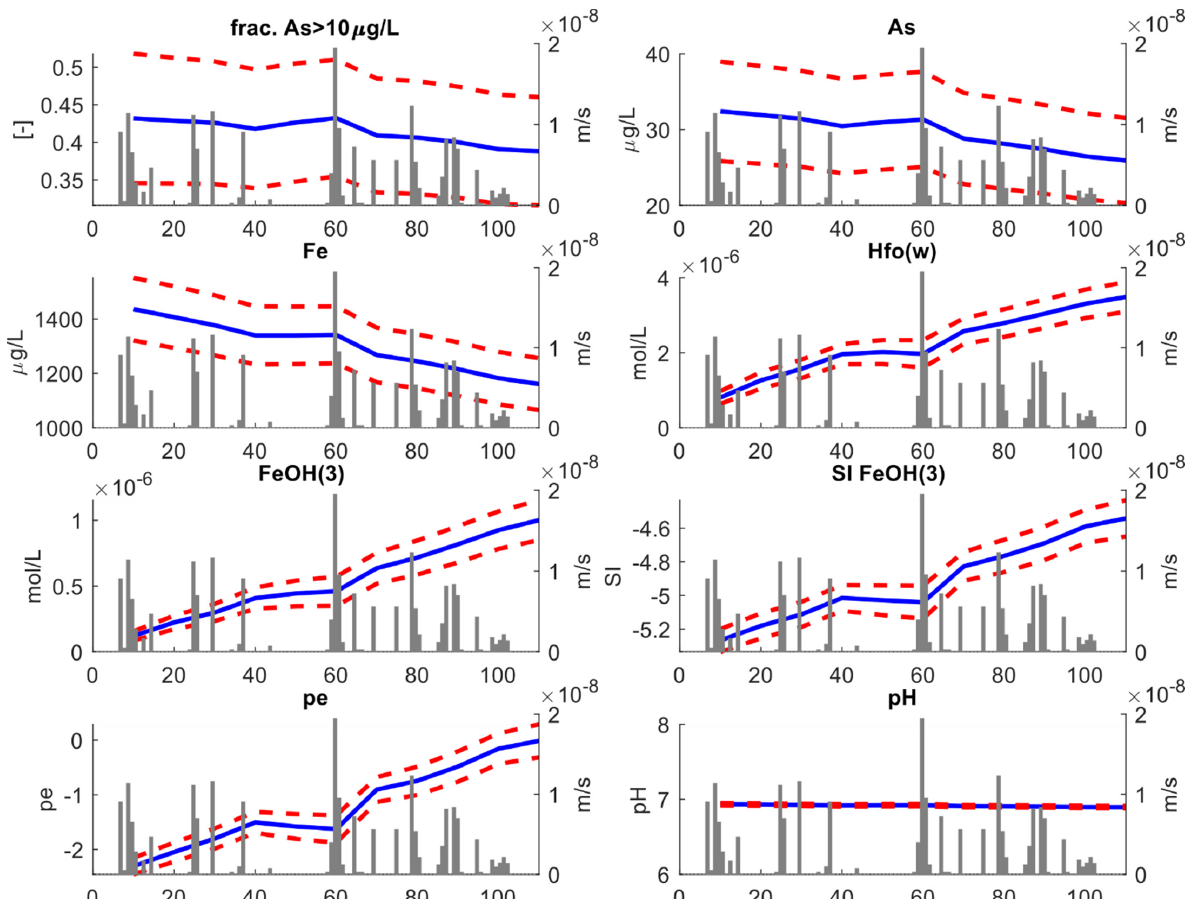
Figure 7. Key results of the stochastic transport analysis. This figure refers to the “full depth” analysis. For each variable, the blue lines reproduce the ensemble mean obtained from averaging over the 100 stochastic simulations, while the red dotted lines represent the 95% (±2 σ ) uncertainty envelop. The gray bars represent the recharge rates (ms − 1 ).